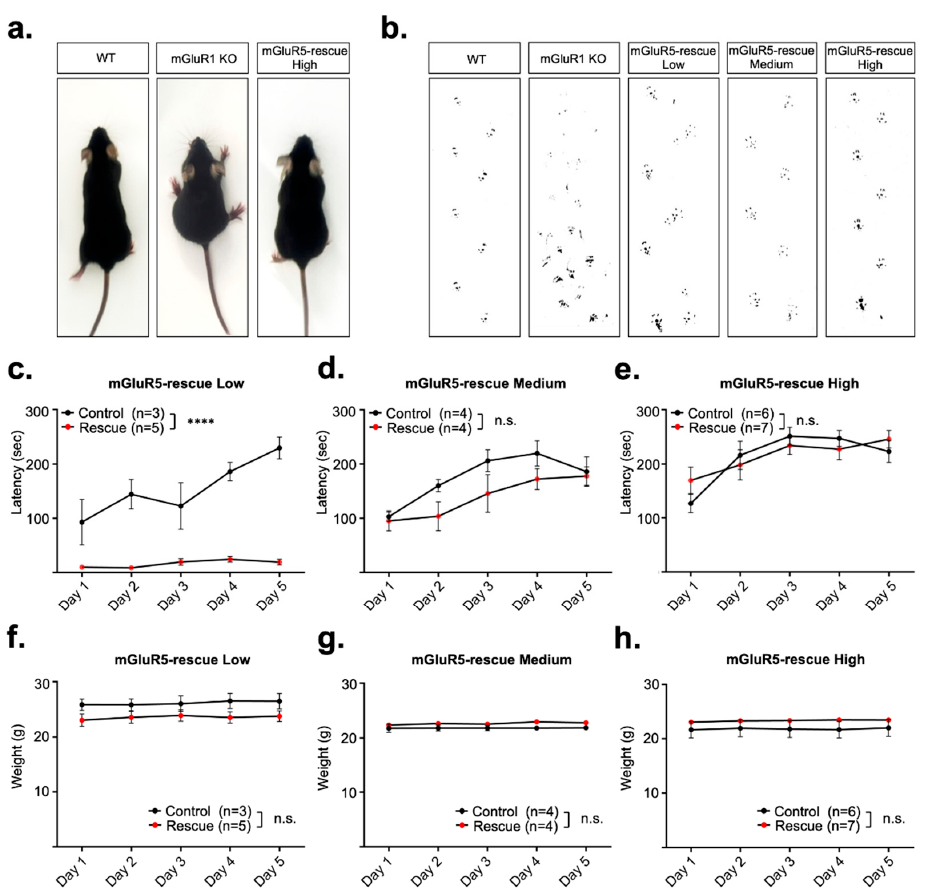
Figure 2. ( a ) Photographs of a wild-type (WT), an mGluR1-KO and an mGluR5-rescue High mouse are shown. mGluR1-KO mouse shows hindlimb spreading, which is improved in mGluR5-rescue mouse. ( b ) Hind limb footprint patterns. ( c – e ) Rotarod test in control mice and mGluR5-rescue Low ( c ), Medium ( d ), and High ( e ) mice. The latency to fall from a rotating rod is plotted versus the